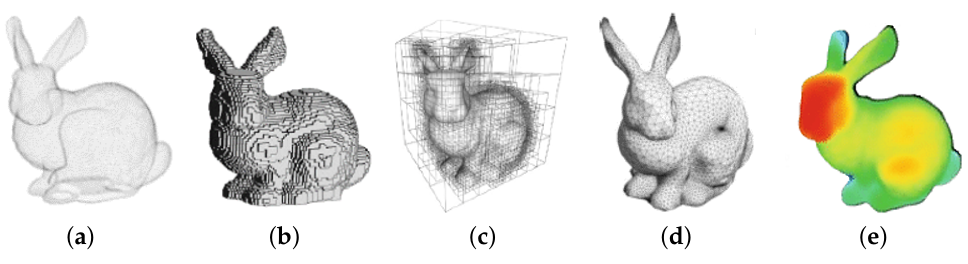
Figure 2. The Stanford Bunny [38] model in different three-dimensional representations. ( a ) Point Cloud, ( b ) Voxels, ( c ) Octree, ( d ) Mesh, ( e )